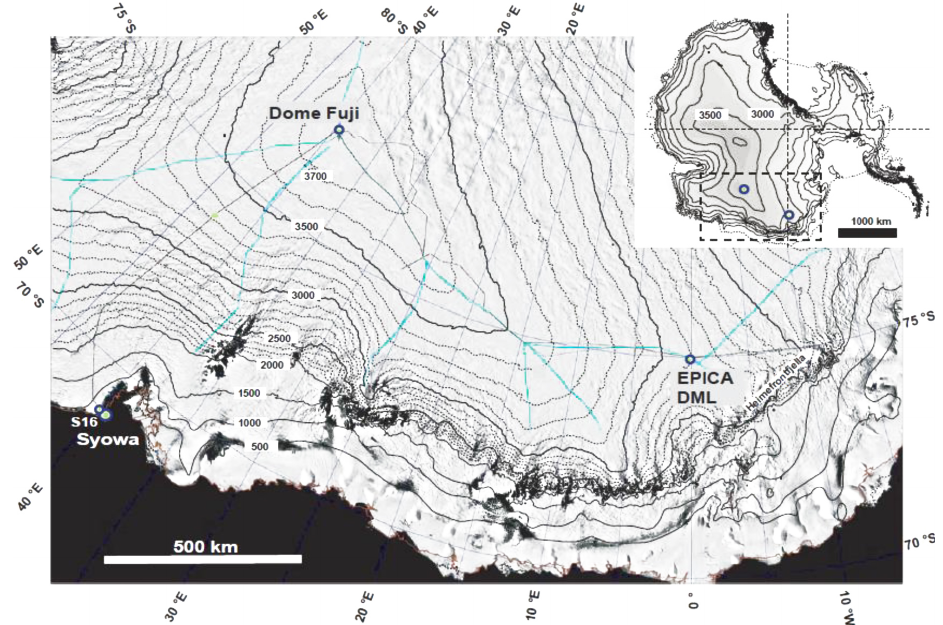
Figure 1. The Atlantic sector of the East Antarctic ice sheet with the positions of Dome Fuji (DF) and the EPICA Dronning Maud Land (EDML) drilling sites. Black lines are elevation curves in metres, blue curves indicate major ice flow lines, and the grey lines are traverse tracks. Satellite image from MODIS (Haran et al., 2005, updated